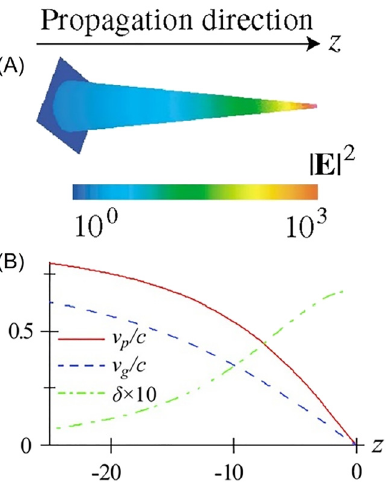
Figure1: (A)SPPs,excitedatthewideendofasilverconeinvacuum (opening angle of 0.04 rad) by electromagnetic radiation at the wavelength of 630 nm, propagate toward the cone's apex. The intensityofthelocalSPP fi eldrelativetotheexcitation fi eldisshown by color with the scale indicated by the color bar in the center. (B) Phase velocity v p , group velocity v g , and adiabatic parameter δ (scaled by a factor of 10) as functions of the coordinate along the silver cone. Figure reproduced with permission from (A) ref. [9], © 2004 APS; (B) ref. [10], © 2011